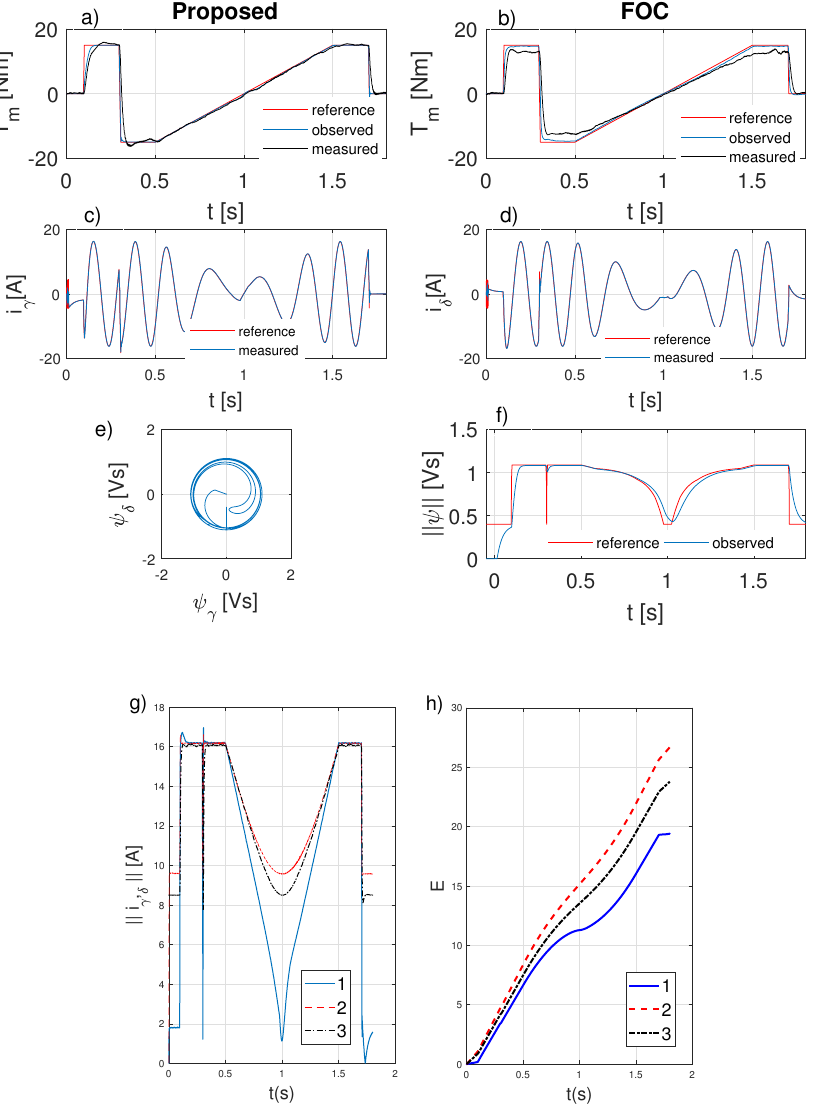
Figure 6. Torque control with optimized rotor flux magnitude command for the torque reversal including zero crossing with a finite slope ( a – f ) and comparison of stator current norm and corresponding integrals ( g , h ) for the proposed controller with optimized rotor flux (1) and with constant rotor flux (2) as well as for field oriented control (FOC) with constant rotor flux